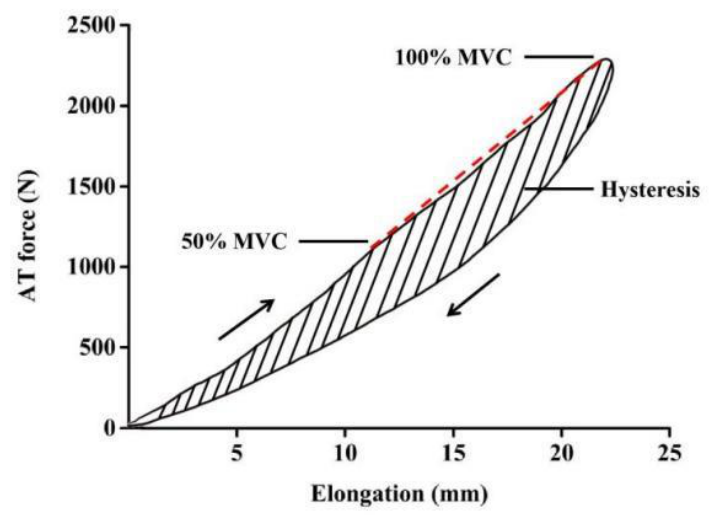
Figure 3. Schematic of tendon stiffness and hysteresis deduction from the Achilles tendon (AT) force–elongation curve. Stiffness (red dashed line) was calculated as the slope of the ascending limb of the AT force–elongation curve at 50–100% maximum voluntary contraction (MVC). Hysteresis was calculated as the area between the ascending and descending limbs.